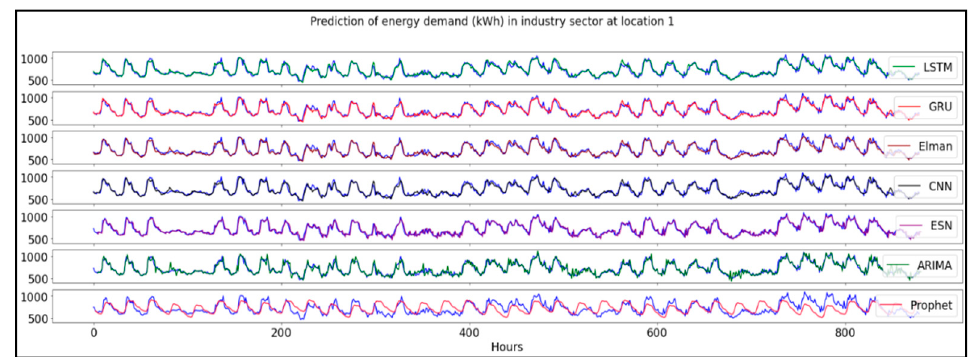
Figure 6. Short-term prediction for industry sector at location 1.